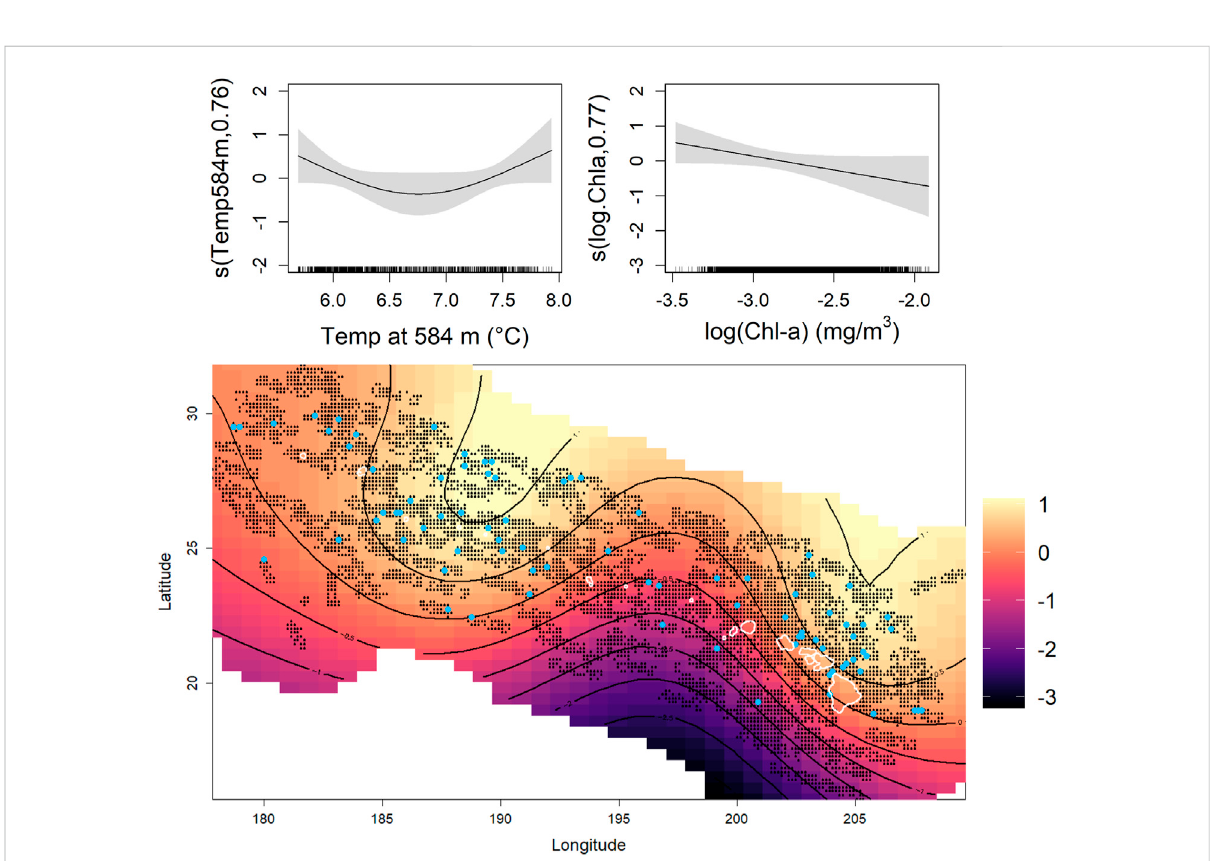
FIGURE 5 Environmental predictorsselected for theforaging modelincluded temperatureat584 m,log of chlorophyll-a concentration [log(Chl-a)],and the 2D spatial term (Longitude, Latitude). Light blue dots on the heat map of the spatial term represent encountered foraging sperm whale groups and the black dots indicate surveyed areas included in the model. The black contour lines represent predicted number of whale groups on the link scale and correspond with the color scale, increasing from dark to light